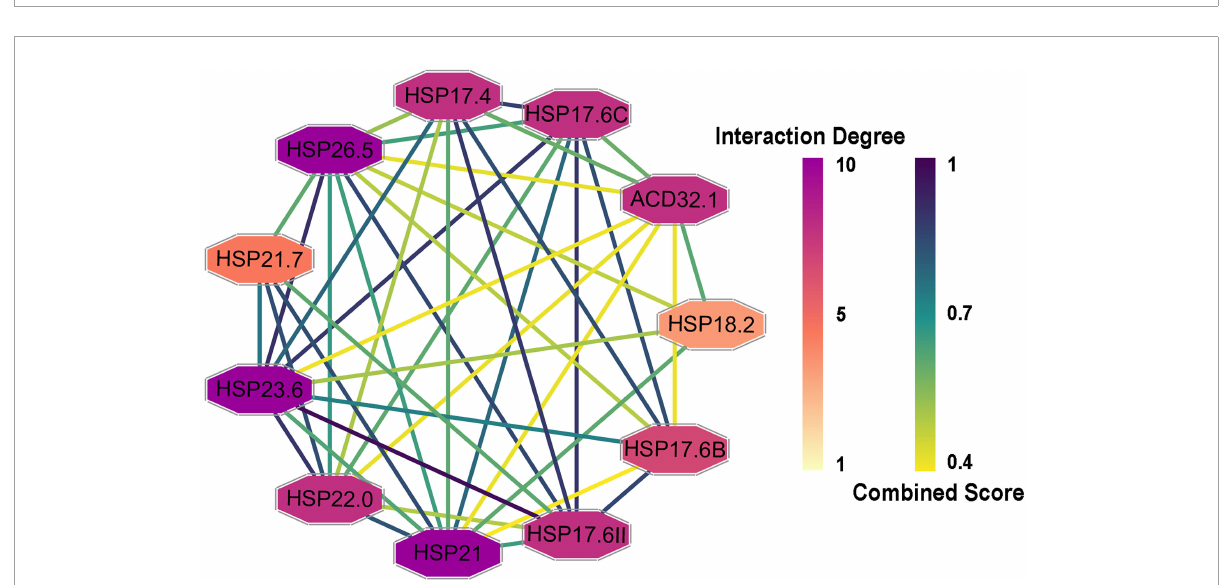
FIGURE5 Protein-protein interaction (PPI) networks of CsHSP20s and their related proteins. The protein node color indicated the interaction degrees linked with each node, and the edge color represented the combined score, the darker the color, the greater the value.